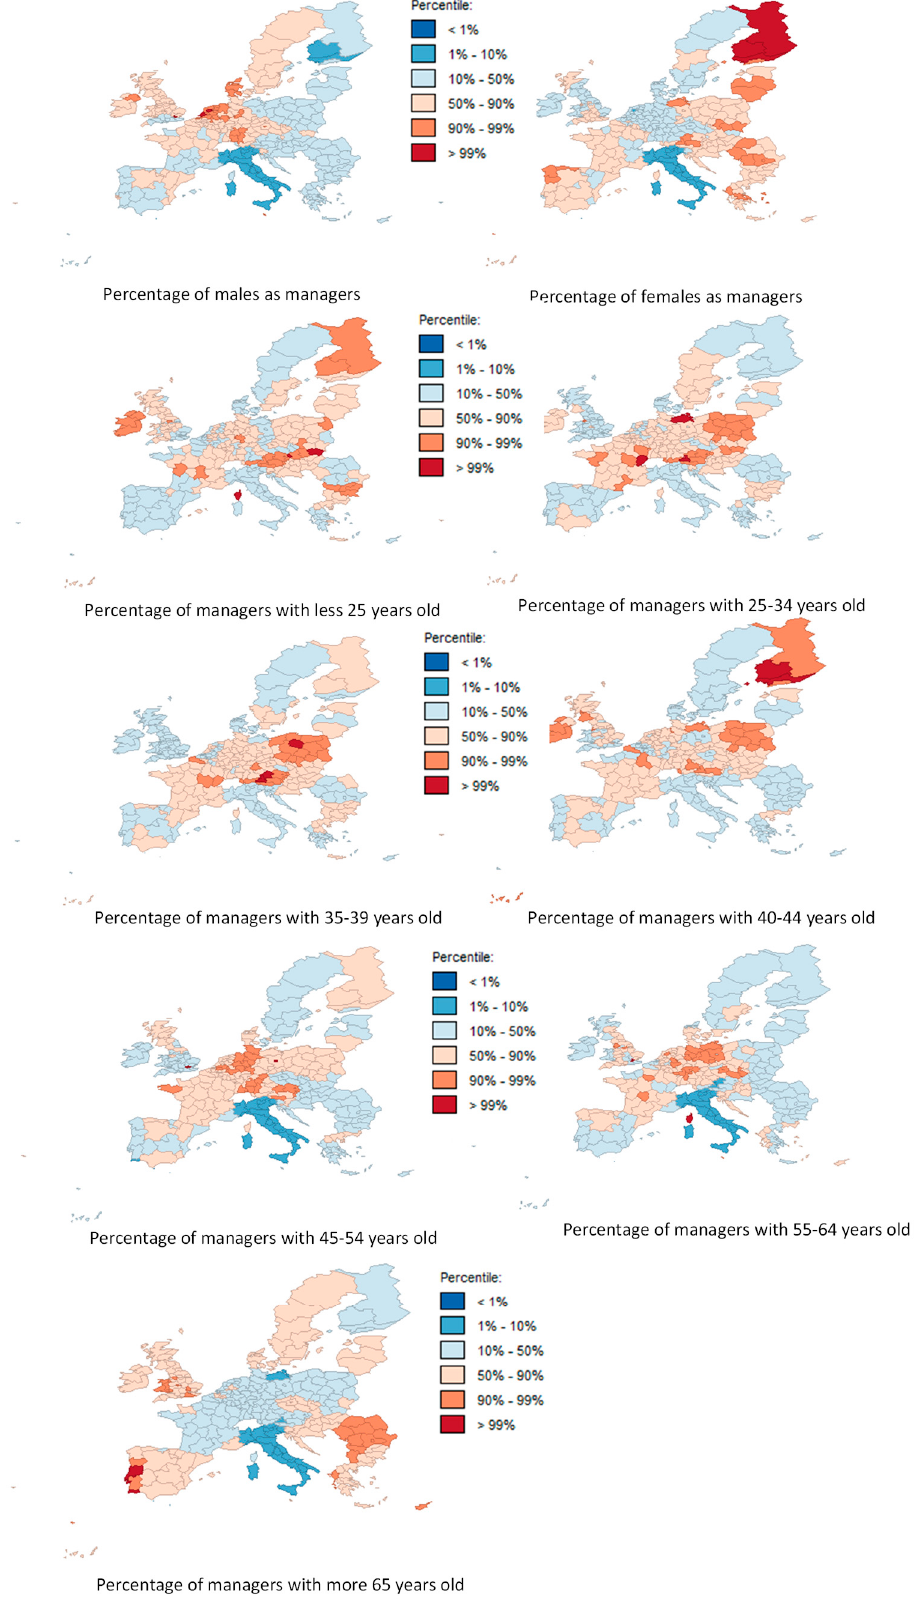
Figure 3. Number of farms disaggregated by gender and age of the managers.